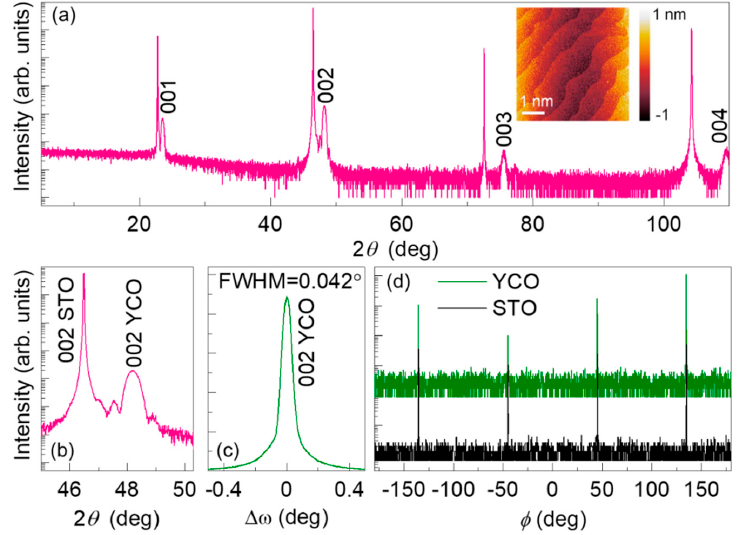
Figure 1. ( a ) Room temperature XRD θ –2 θ line scan of the 32-nm YCrO 3 (YCO) film grown on SrTiO 3 (STO) (001) substrate. Inset shows the atomic force microscopy (AFM) image of the same sample. ( b ) ( b ) The θ –2 θ local scan around the substrate (002) peak. ( c ) A rocking curve of the YCO (002) peak